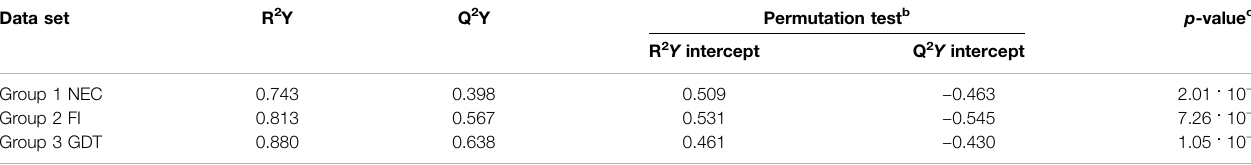
TABLE 2 | Statistical parameters of the OPLS models derived from the 1 H-NMR spectra of urine samples from group 1 NEC, group 2 FI, and group 3 GDT cases. a